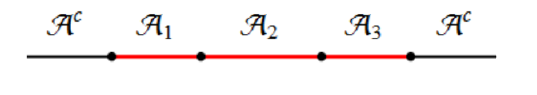
Figure 1 . The partition of an single interval, A = A 1 [ A 2 [ A 3